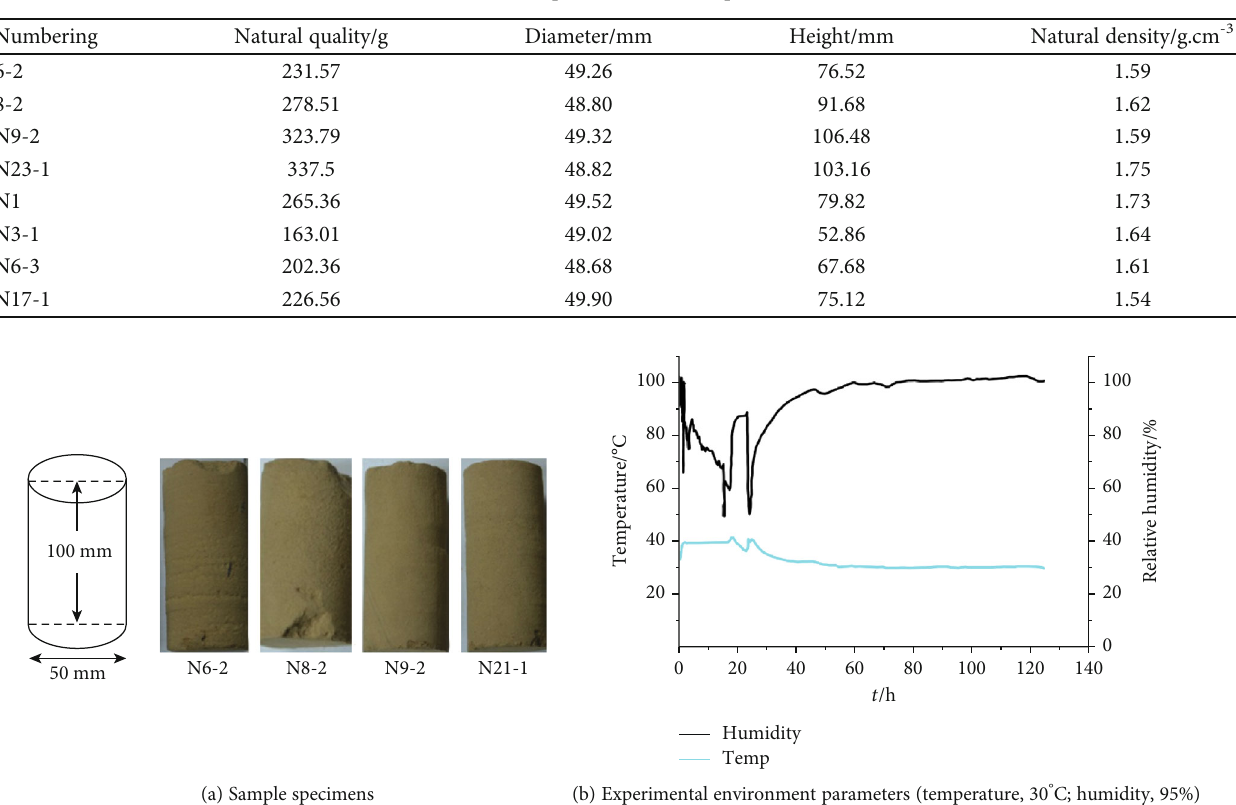
Table 5: Basic parameters of the specimens.